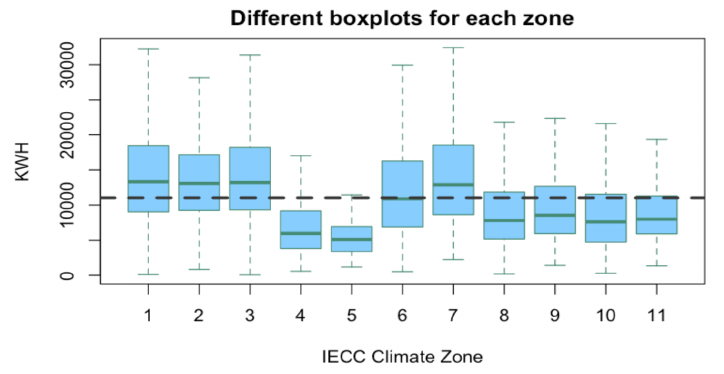
Figure 9. Box-plot for each IECC climate zone and their site electricity usage in kWh.